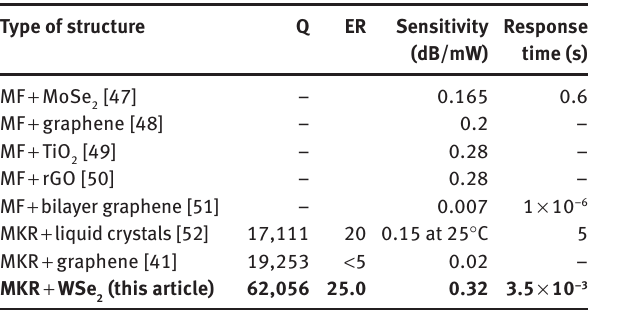
Table 2: Property index of different types of light–control–light